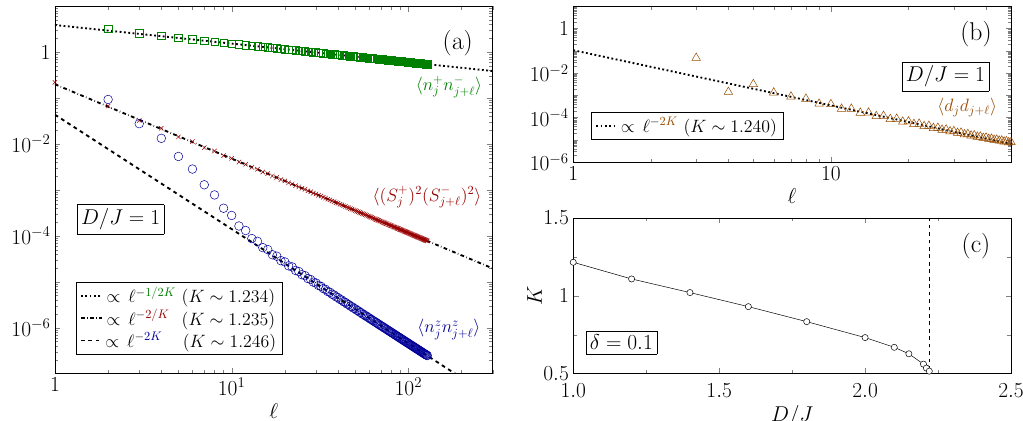
Figure 3: Spin-spin (a) and dimer-dimer (b) correlation functions at the c = 1 tran- sition for D / J = 1 and δ = 0.1 computed by iDMRG with bond dimension χ = 1600. The extracted values of the LL parameter K are in good agreement. (c) Extrapolated values of LL parameters K via S ( q ) of Eq. (44) on the c = 1 transition line for δ = 0.1, obtained by DMRG with up to L = 1024 sites and open boundary